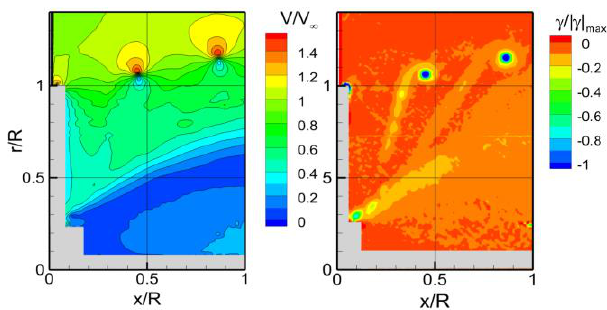
Fig. 3 Average velocity (left) and vorticity field (right), 1500rpm.